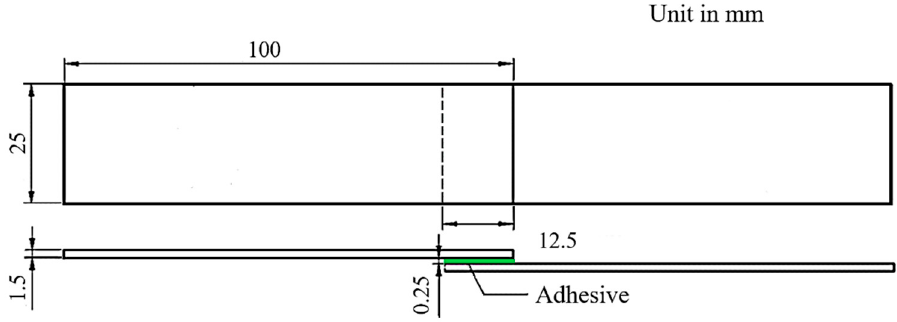
Figure 3. Configuration of the adhesive-bonded CFRP joint.